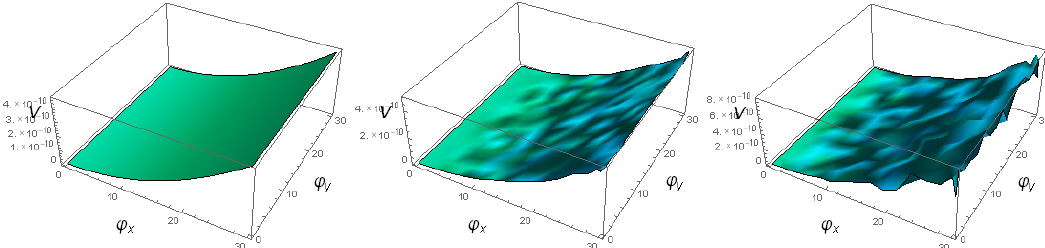
Figure 1 . Potential surface with null, small and large randomness. We choose (cid:1) x ’ = 0 : 05, m = 10 (cid:0) 6 , ’ max = 30, and A = 0 ; 0 : 1 ; 1 respectively for the left, middle and right (cid:12)gure. The distribution is uniform for random numbers in the interpolation function, and the interpolation is for C 1